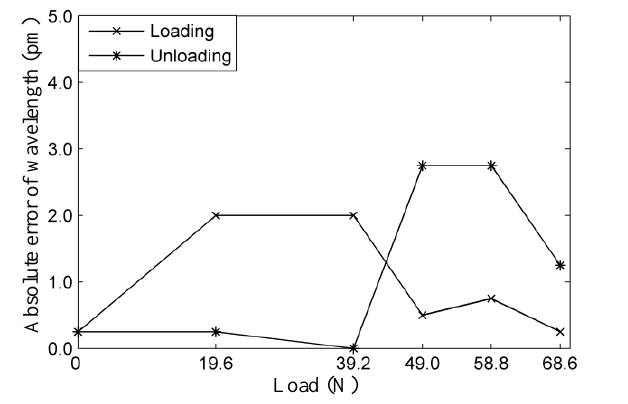
Figure 6. Wavelength absolute error of the FBGs sensor under loading and unloading conditions.